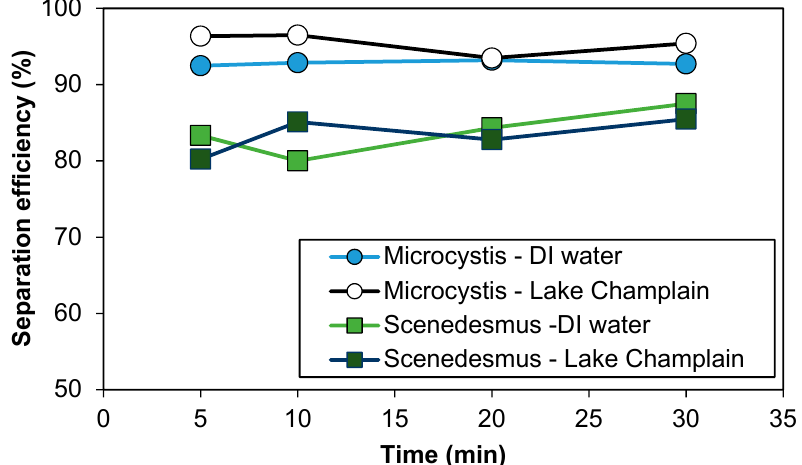
Figure 3. Separation e ffi ciency of cells in the overflow and underflow of the mini-hydrocyclone over time.